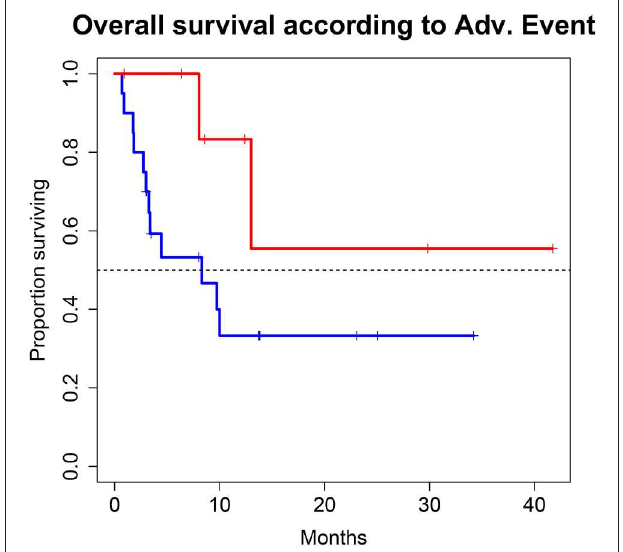
FIGURE 4 | Overall survival (OS) for 28 patients under second line therapy with checkpoint inhibitor monotherapy for metastatic urothelial carcinoma according to occurrence of immune related adverse events [Grade 0-1 (blue) vs. ≥ 2 (red)]. OS differed in favor for patients with immune related adverse events (8.3 months vs. not reached, p -value = 0.1067), however this difference was not statistically significant.